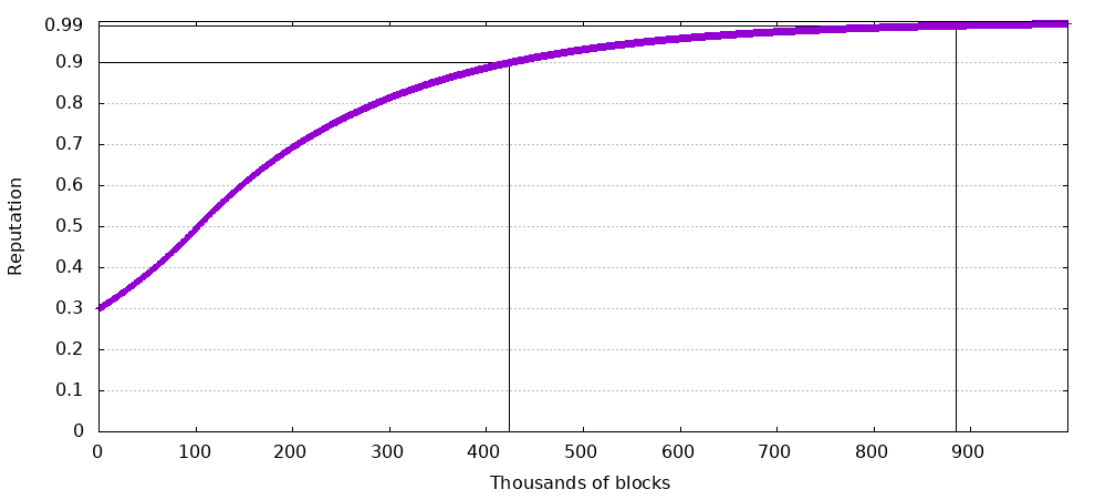
Figure 7. Reputation change over time (speedCoefficient = 1 × 10 − 6 ).